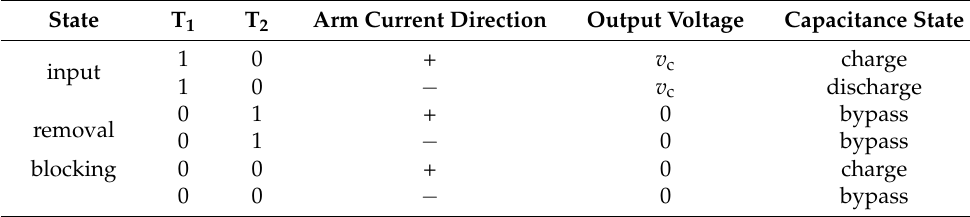
Table 1. The operating state of MMC.